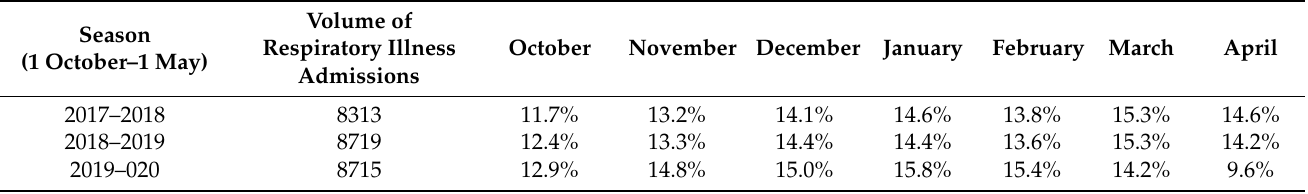
Table 2. Total Yearly Volume and Monthly Rate * of Patients Admitted to UAMS with an ICD-9 or ICD-10 code Correlated to Respiratory Illness.